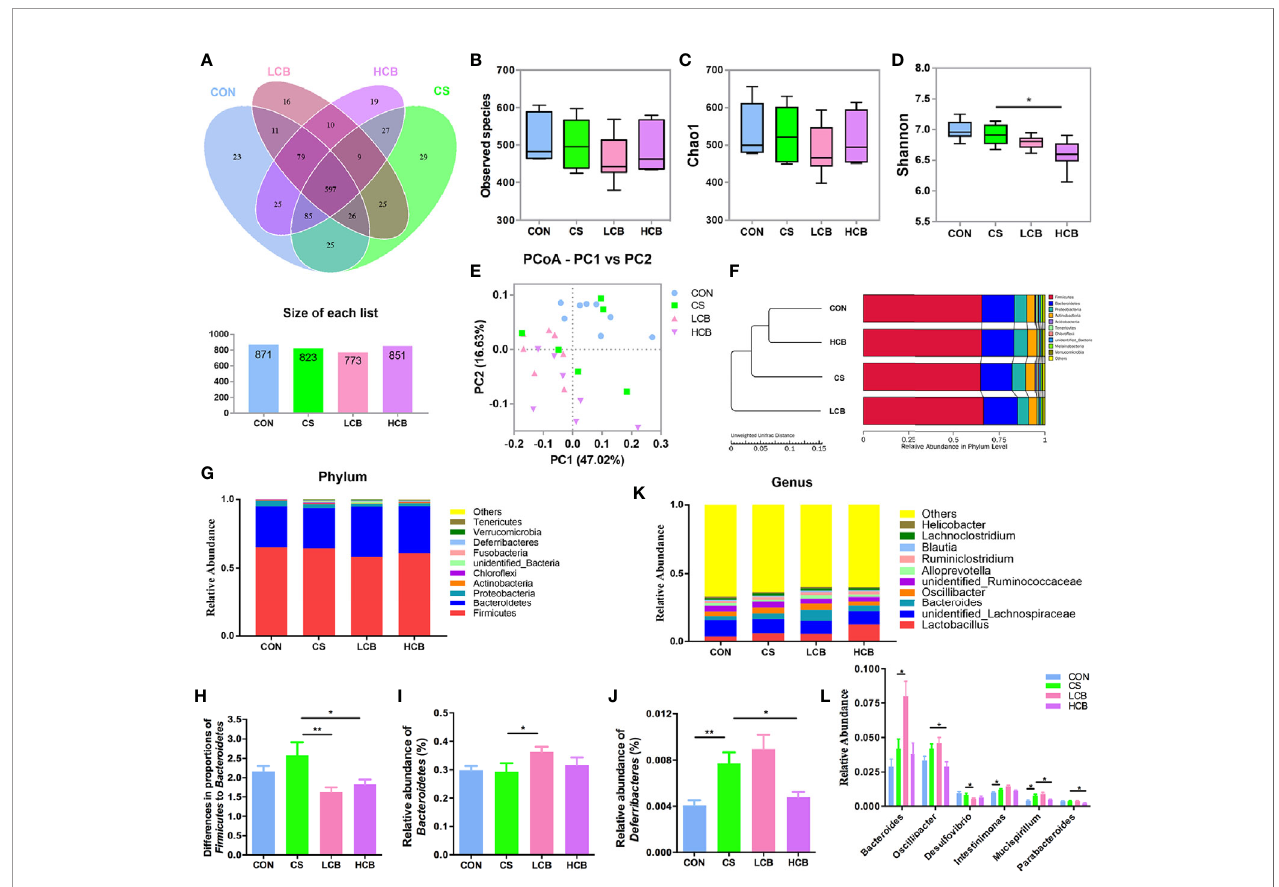
FIGURE 2 | Evaluation of illumina HiSeq sequencing data showing that CB RH2 could modulate the structure and composition of gut microbiota. (A) Venn diagram of shared and independent bacterial OTUs in different experimental groups (n >6); (B – D) Analysis of a -diversity of gut microbiota by Observed species, Chao1 and Shannon index; (E) Principal coordinate analysis (PCoA) based on weighted Unifrac distances among different samples. PC1 and PC2 account for 63.65% of the variation; (F) Multivariate analysis of variance from PCoA matrix scores using UPGMA method based on weighted Unifrac distances; (G) The average abundance of microbial community in different mice groups at phylum level; (H) The ratio of Firmicutes to Bacteroidetes ; (I, J) Statistical analysis for Bacteroidetes and Deferribacteres at the phylum level; (K) Bar charts at genus level of gut microbiota in the four groups; (L) Relative abundance of Bacteroides , Oscillibacter , Desulfovibrio , Mucispirillum and Parabacteroides are signi fi cantly manipulated by CB RH2 at genus level. Statistical analysis was performed using the t tests method. All values are mean ± SEM (n >6). *p < 0.05, **p <